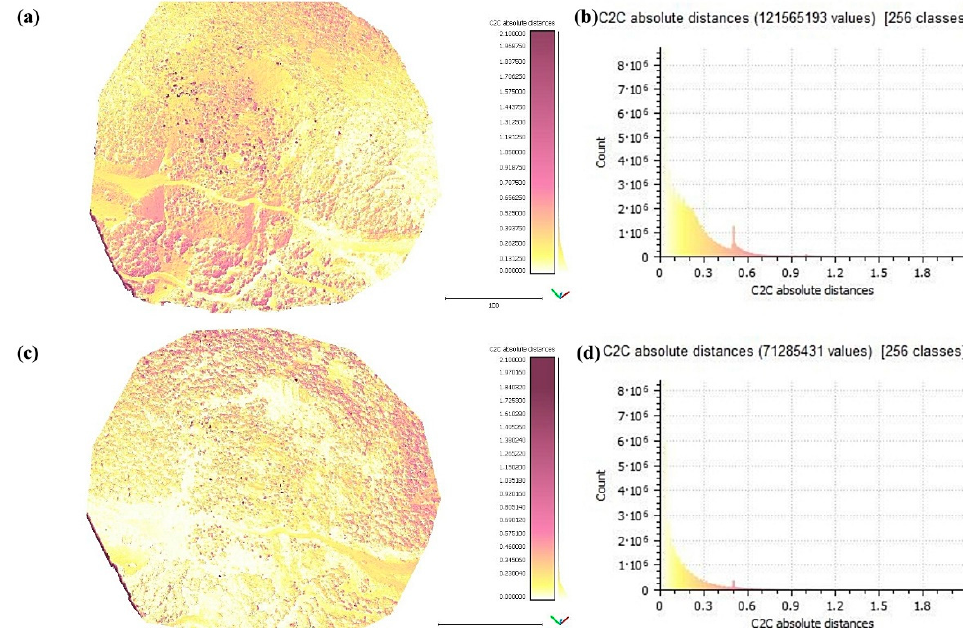
Figure 11. Cloud-to-cloud distances. ( a ) C2C distances between the point cloud of nadir-oblique imagery and the corresponding one of nadir-viewing geometry, acquired on 25 July 2018. ( b ) Histogram of C2C distances between the point cloud of nadir-oblique imagery and the corresponding one of nadir-viewing geometry, acquired on 25 July 2018. ( c ) C2C distances between the point cloud of nadir-oblique imagery and the corresponding one of oblique-viewing geometry, acquired on 25 July 2018. ( d ) Histogram of C2C distances between the point cloud of nadir-oblique imagery and the corresponding one of oblique-viewing geometry, acquired on 25 July 2018.